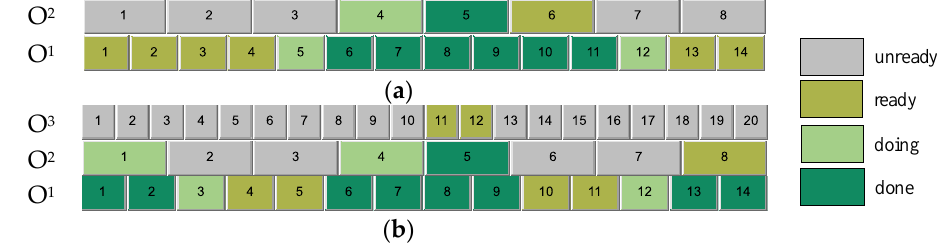
Figure 15. Simulation result in the flow-shop ( a ) Two-operation and ( b ) Three-operation working modes.